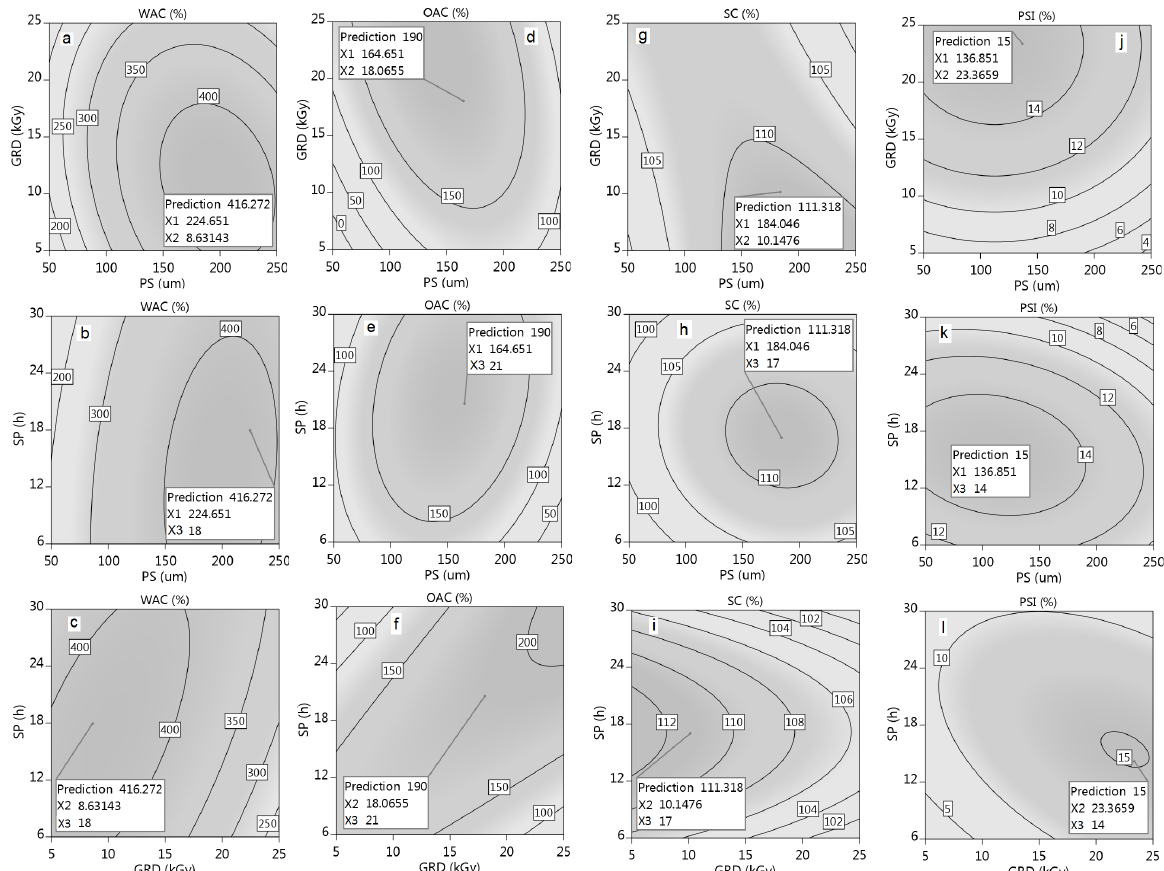
Fig. 3: Optimum levels of process variables for the optimal response of functional properties of N. nucifera rhizome flour a-c) WAC, d-f) OAC, g-i) SC, and j-l) PSI X1: PS, X2: GRD, X3: SP PS: Particle size, GRD: Gamma radiation dose, PS: particle size, WAC: water absorption capacity, OAC: Oil absorption capacity, SC: Swelling capa- city, PSI: protein solubility